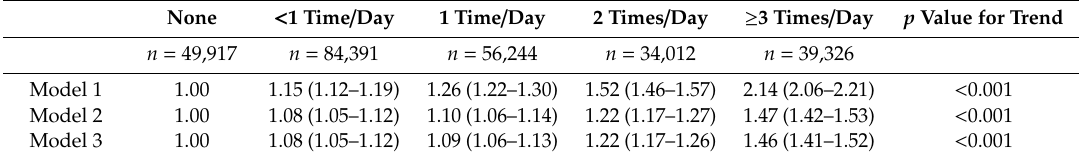
Table 2. Odds ratio (95%CI) for aggressive behavior by soft drink consumption levels ( n = 263,890) 1 . <1 time/day